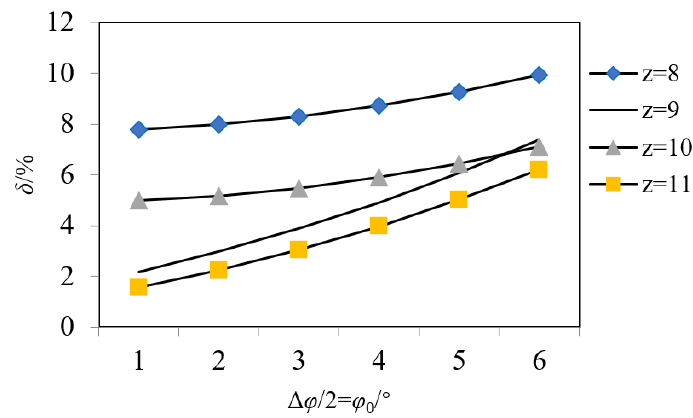
Figure 12. Output flow pulsation rate curve of piston pumps with 8~11 pistons under 6 flow distribution boundary conditions.